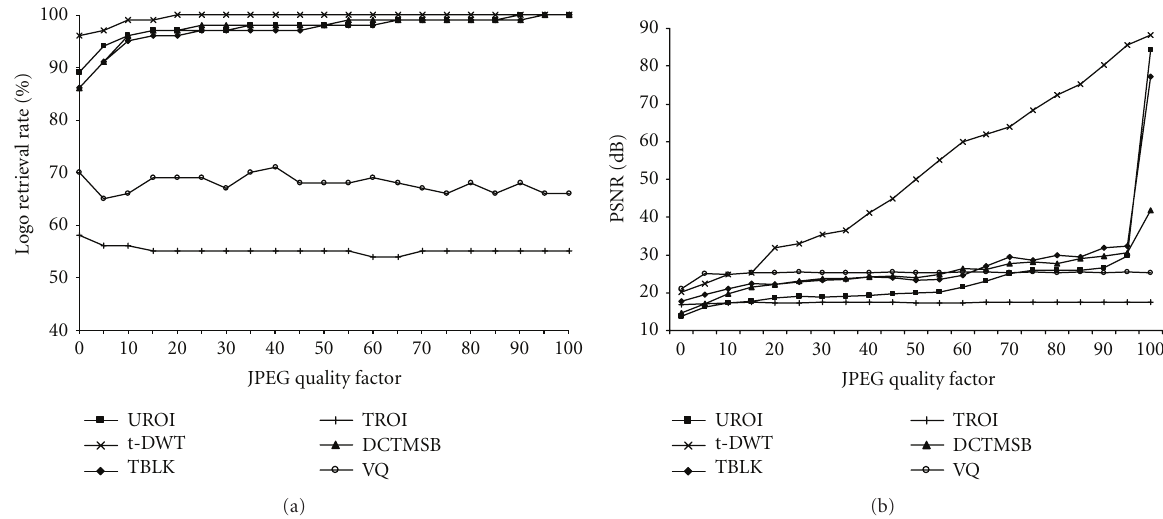
Figure 5: (a) Logo retrieval rate and (b) PSNR using Elaine image and NUS logo by di ff erent approaches of the proposed MSB-based scheme and existing TROI-based [12] and VQ-based [13] schemes under di ff erent JPEG quality factors.